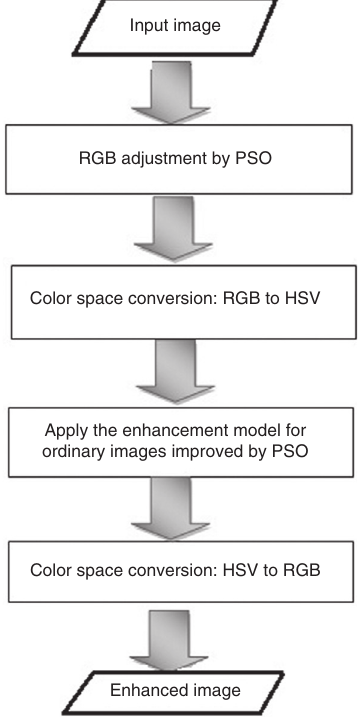
Figure 2. Block Diagram for the Underwater Image Enhancement